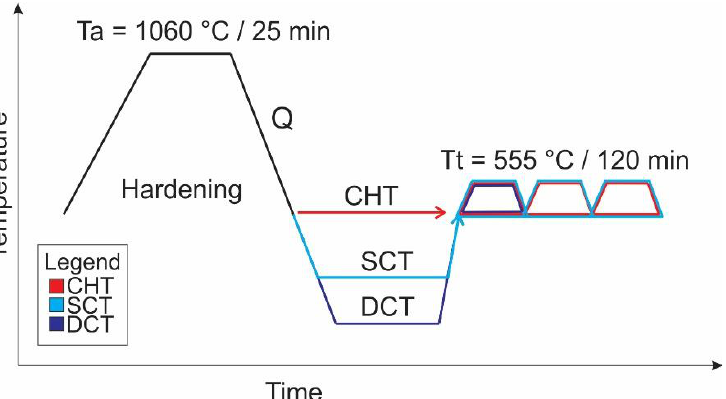
Figure 1. Scheme of all three heat treatments (CHT = conventional heat treatment, SCT = shallow cryogenic treatment and DCT = deep cryogenic treatment) with selected heat treatment temperature (Ta = austenitization temperature and time and Tt = tempering temperature and time).